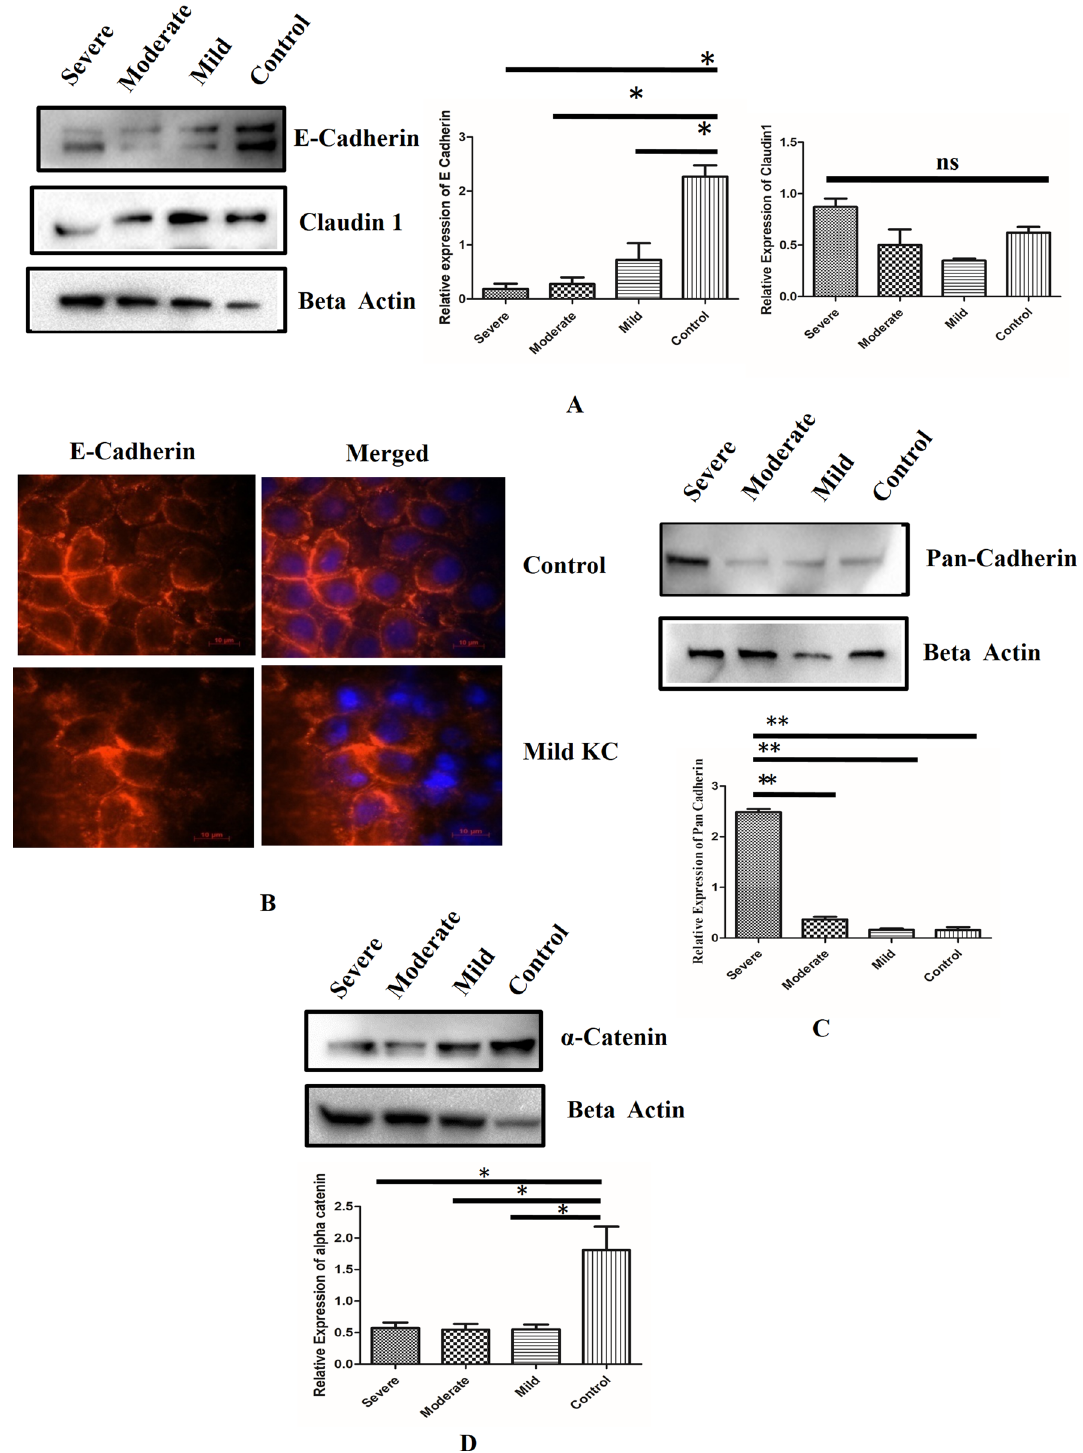
Figure 2. (A) Immunoblotting of control, mild, moderate and severe keratoconic epithelium with E cadherin and Claudin1 (n = 7) ( Full blot was cut in three halves for probing E cadherin, claudin and beta actin image is represented in Fig S8) (B) Tissue immunofluorescence of E cadherin in control and mild keratoconic epithelium (n = 7) Scale bar-10 µM (C) Immunoblotting of Pan cadherin in control, mild, moderate and severe keratoconic epithelium.(n = 7).(Full blot was cut in two halves for probing pan cadherin and beta actin image is represented in Fig S9). (D) Immunoblotting of α-catenin incontrol, mild moderate and severe keratoconic epithelium.(n = 7) (Full blot was cut in two halves for probing alpha catenin and beta actin image is represented in Fig S10).One way ANOVA Asterisks *, **, and *** denote a significance with p Values < 0.05, 0.01, and 0.001